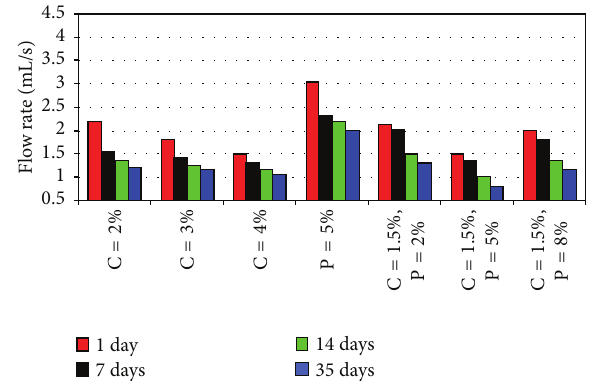
Figure 9: Comparison of results from pinhole tests.